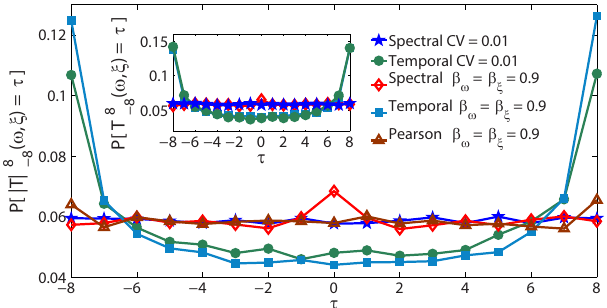
(ω(t),ξ(t)) and T 8 − (ω(t),ξ(t)) Figure 8. The distribution of | T | 8 − 8 8 (inset) for different time delay estimates when (i) both signals have long-range autocorrelations, β ξ = β ω = 0 . 9 and (ii) both signals are i.i.d. and ω(t) has a CV of 0 . 01. We can see that the frequency domain estimator (Spectral), Eq. (14), is free of the bias seen for the estimator given by (Temporal), Eq. (3). We also show the result of using the Pearson correlation (Pearson) – here the bias is greatly reduced, but still peaked at extreme lags. Fixed parameters are: (cid:127) = 17, with N = 2 16